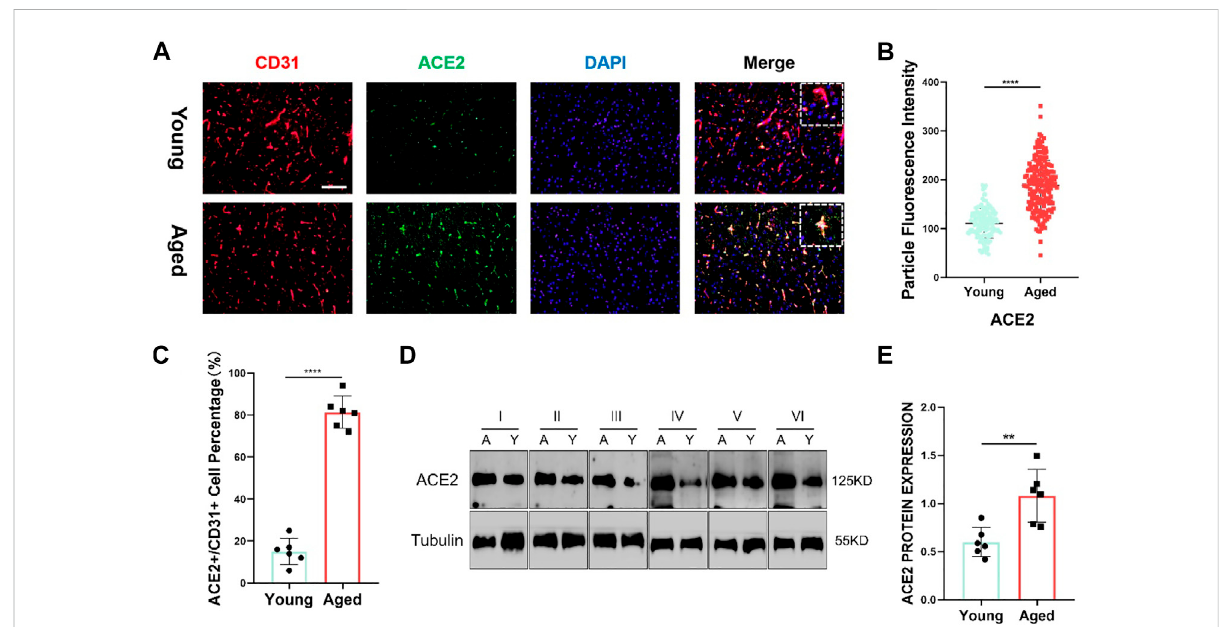
FIGURE 6 (A) Representative images of immuno fl uorescence staining for CD31 (red), ACE2 (green) and DAPI (blue) in the juvenile and aged Sprague – Dawley (SD) rats. Scale bar = 100 μ m; n = 6. (B,C) ACE2 shows a signi fi cant difference between the two groups. Data are presented as mean ± standard deviation (SD); **** p -value < 0.0001; n = 151 and 183 (D) Representative western blot images of ACE2 and tubulin from the two groups. n = 6. (E) Tubulin was used as a protein loading control; mean ± SD of eight independent experiments. ** p -value <